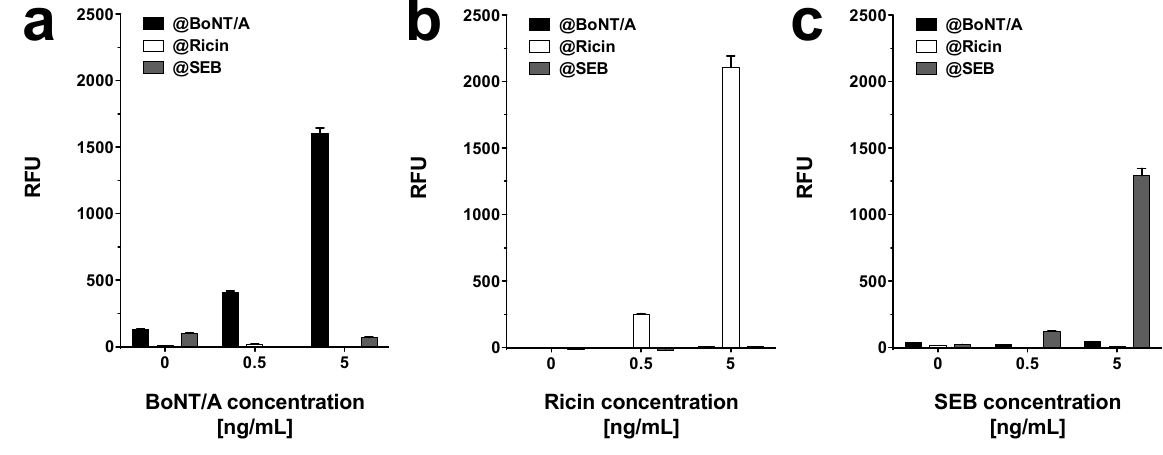
Figure 5. Cross-reactivity of anti-toxin antibodies. PBS was spiked with 0.5 and 5 ng·mL − 1 of ( a ) BoNT/A, ( b ) ricin, and ( c ) SEB, respectively, and slides were processed at 37 °C (BoNT/A and ricin) and 25 °C (SEB). Signals are shown for the spiked toxin, as well as signals measured at features functionalized with capture antibodies against the other toxins. Signals measured at anti-BoNT/A (@BoNT/A) coated features are depicted in black, signals at anti-ricin (@Ricin) coated features in white, and signals at anti-SEB (@SEB) coated features in gray. Average signal intensity and standard deviation (error bars) were derived from six features (n = 6) per